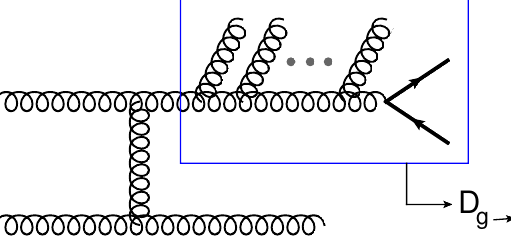
Figure 12 . A contribution to heavy-quark production resummed by DGLAP equations in GM- VFNS calculation. The diagram has been drawn with JaxoDraw 2.1 [47].